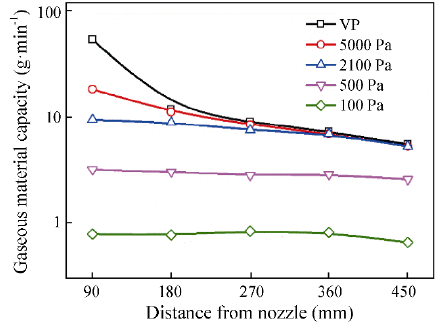
Fig. 74 Thermodynamic carrying capacities of the plasma jet. VP represents the vapor pressure of ZrO 2.